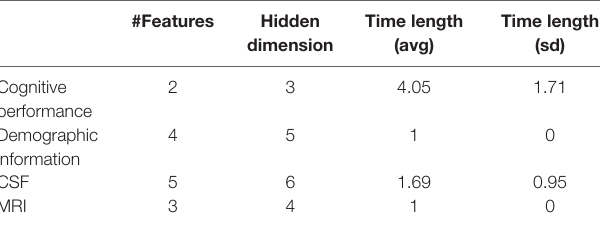
TABLE 1 | Summary statistics for data and hyperparameters in the experiment with real